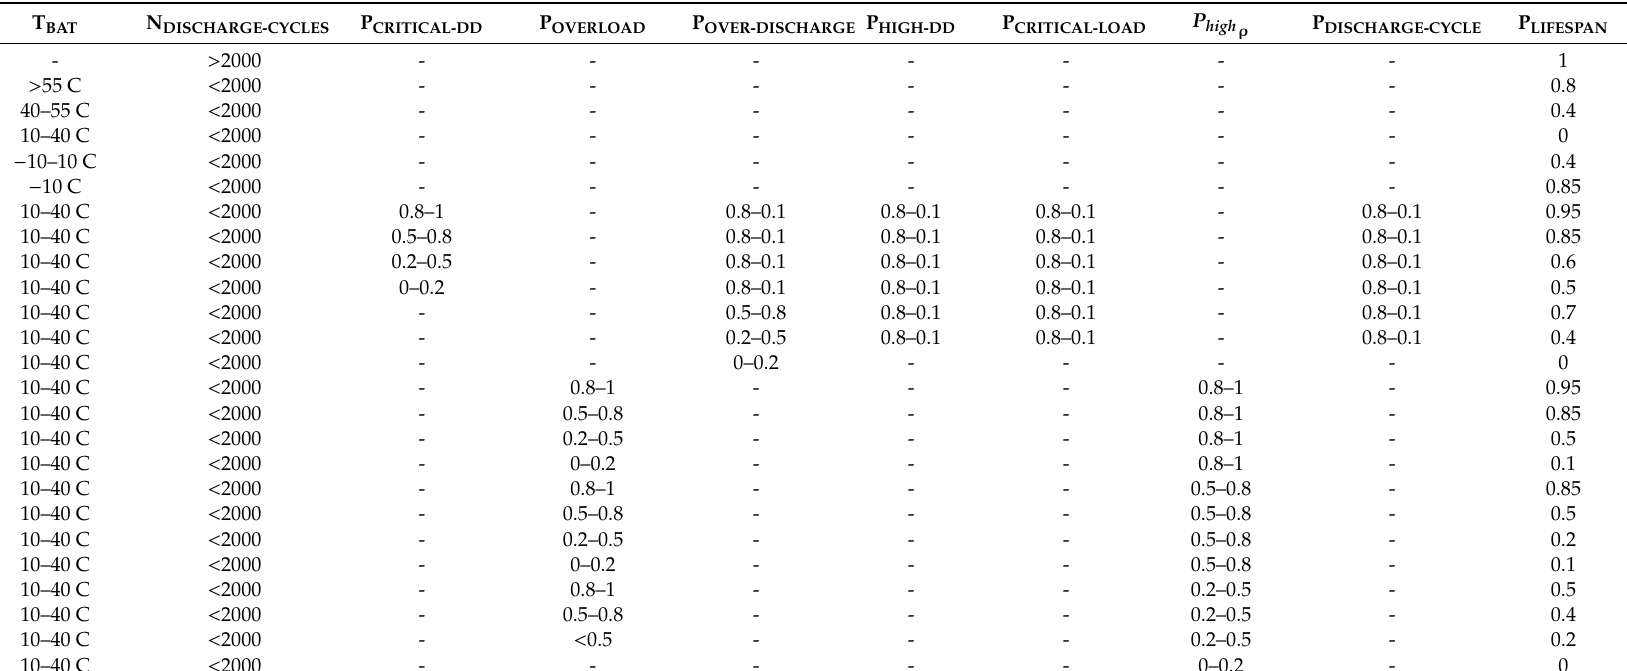
Table 11. Probabilities and possible states for battery